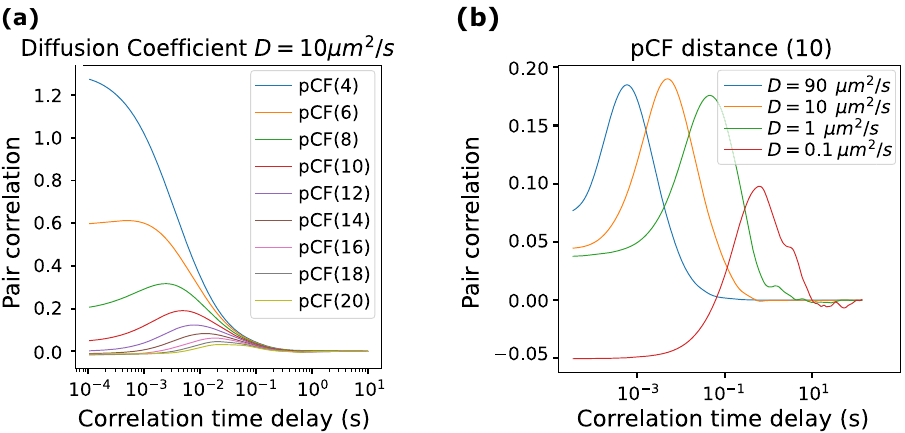
Figure 8. pCF simulated data. To build confidence on the interpretation of our experimental results, we simulated (SimFCS, www. lfd. uci. edu) different scenarios where molecules (proteins) diffuse in a 64 pixels (1 pixel = 50 nm) cubic box with defined diffusion coefficients and molecular brightness. ( A ) pCFs at different distances from 4 to 20 pixels are calculated and displayed in different colors. The maximum of the pCF curve moves at longer correlation times while the amplitude decreases as the computed distance increases. ( B ) pCFs calculated at a distance of 10 pixels for different values of the diffusion coefficient. The maximum of the pCF(10) moves at longer correlation times as the diffusion coefficient